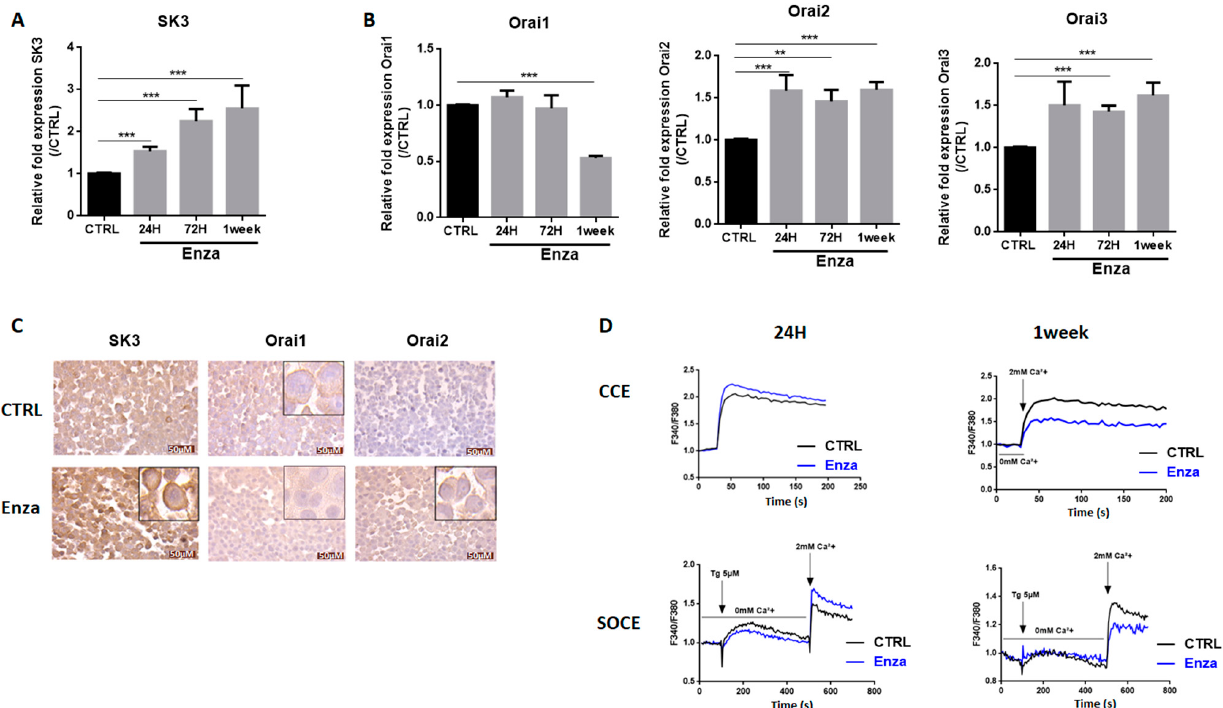
Figure 4. AR inhibition deregulates calcium signaling. ( A , B ): Enza first increases Orai2, Orai3, and SK3 expression and later, after a 1-week treatment decreases Orai1 expression. LNCaP cells were treated for 24 h, 72 h, and 1 week with the Enza (10 µM). qPCR results are normalized to the control condition and are expressed as mean ± S.E.M. The statistical differences are indicated: ** p < 0.01; *** p < 0.001 (Kruskal–Wallis; post-test: Dunn) n = 3; ( C ): Expression of SK3, Orai1 and Orai2 proteins in LNCaP cells treated with Enza for 1 week. Immunohistochemical staining was performed on cell pellets; ( D ): Two main calcium entry pathways (CCE and SOCE) were measured by fluorimetry with the Fura2-AM probe. LNCaP cells were treated with Enza (10 µM) for 24 h and 1 week. Results are represented by calcium curves illustration.